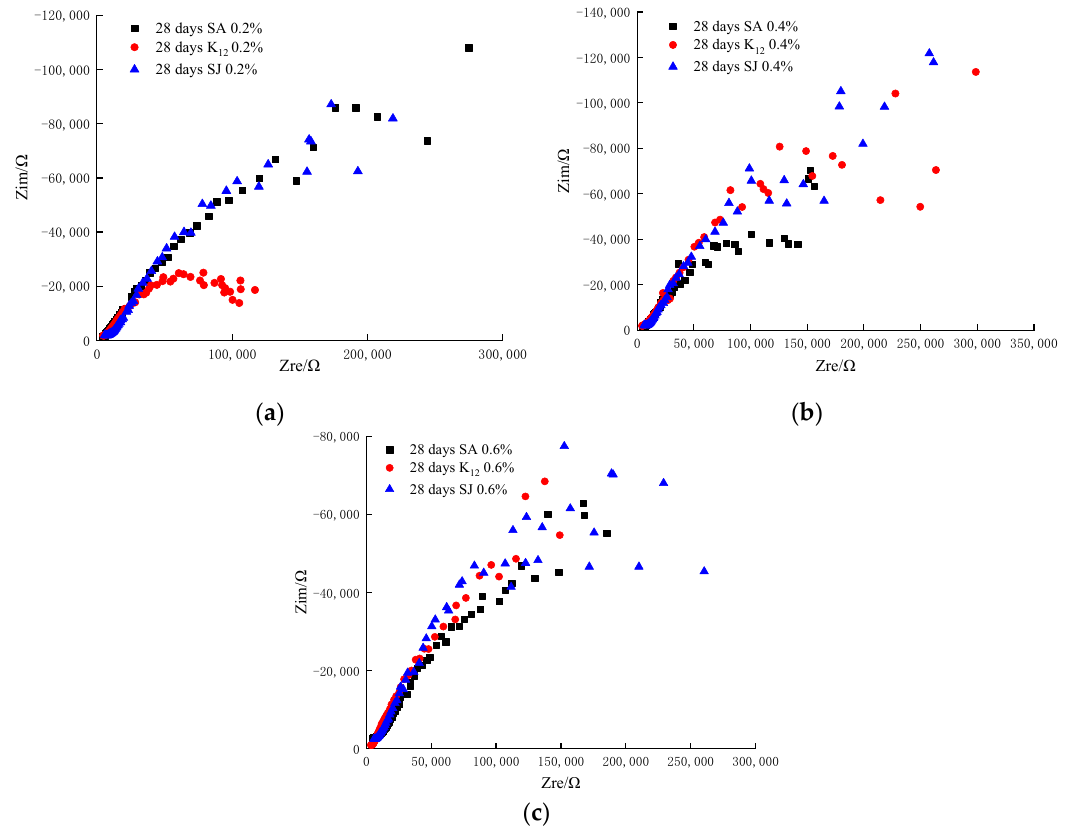
Figure 7. Nyquist diagram of the filling body with the same amount of AEA for 28 days of curing age. ( a ) Add 0.2% SA, K 12 and SJ, respectively; ( b ) Add 0.4% SA, K 12 and SJ, respectively; ( c ) Add 0.6% SA, K 12 and SJ, respectively.